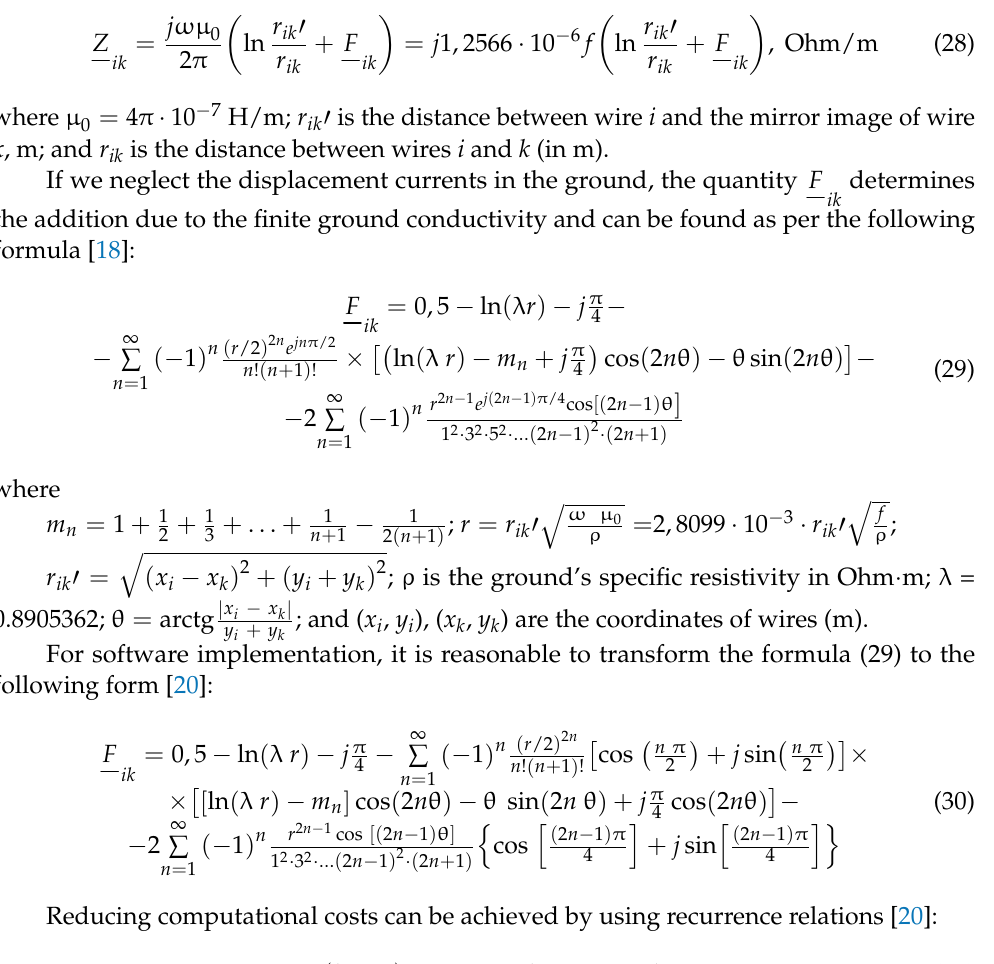
Figure 5. Original circuit of the power transmission line.